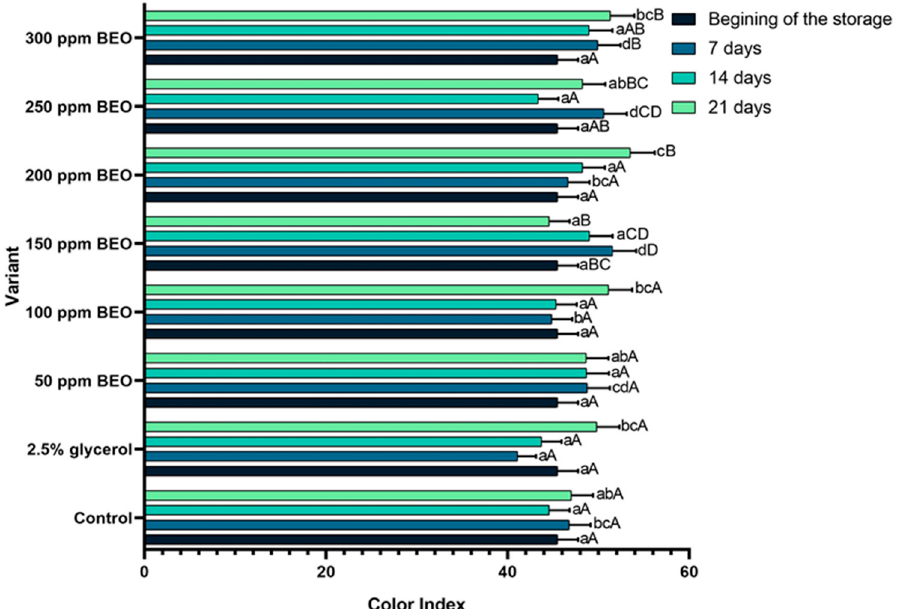
Figure 8. Effects of applied treatments on the Color index (fruit color parameter) during storage for 21 days at 8 ± 1 °C. Bars for the same sampling time followed by different lowercase letters are significantly different based on the least significant difference (LSD) test ( p < 0.05). Bars for the same treatment during storage time followed by different uppercase letters are significantly different based on the least significant difference (LSD) test ( p < 0.05).